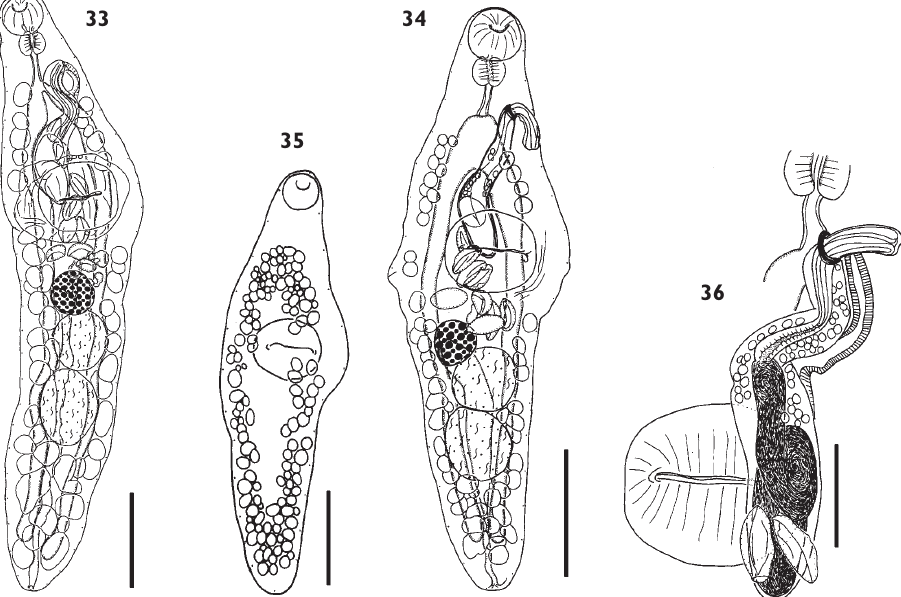
Figs 33-36. Macvicaria adomeae n. sp. ex Sillaginodes punctatus . 33. Whole-mount ventral view. 34. Whole-mount ventral view. 35. Dorsal distribution of vitelline follicles. 36. Terminal genitalia. Scale bars : 33, 34, 35, 250 μm; 36, 100